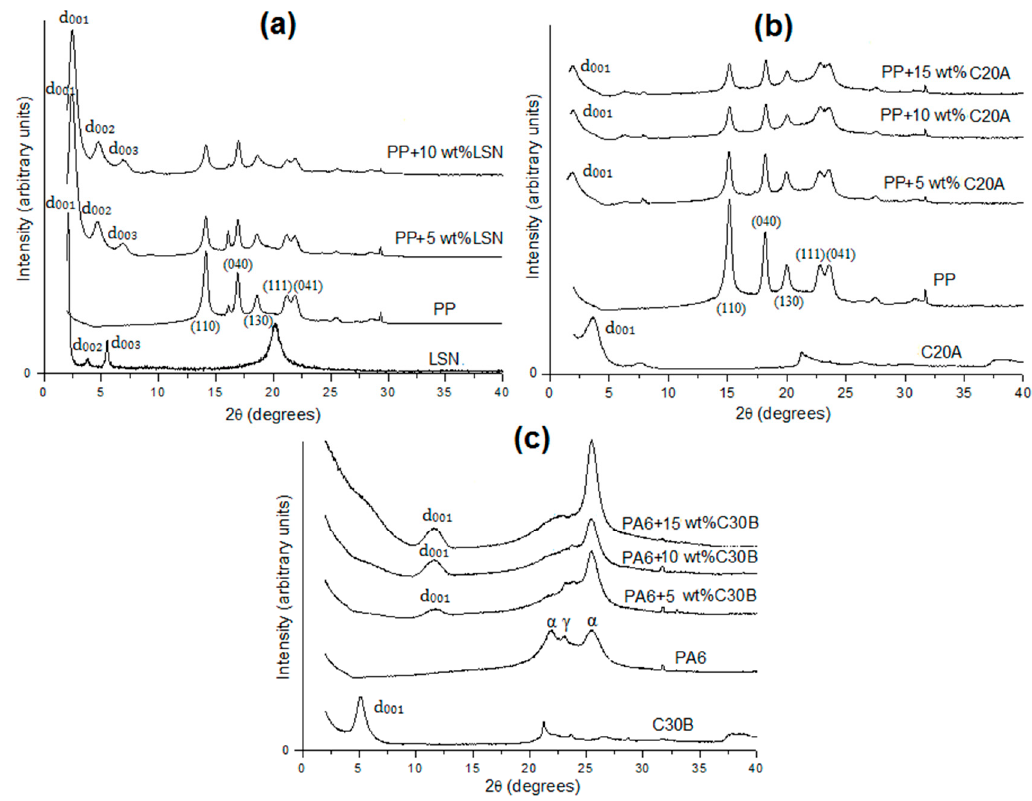
Figure 1. X-ray diffractograms of nanoparticles, polymer matrices, and nanocomposites: ( a ) PP/LSN; ( b ) PP/C20A; and ( c ) PA6/C30B.